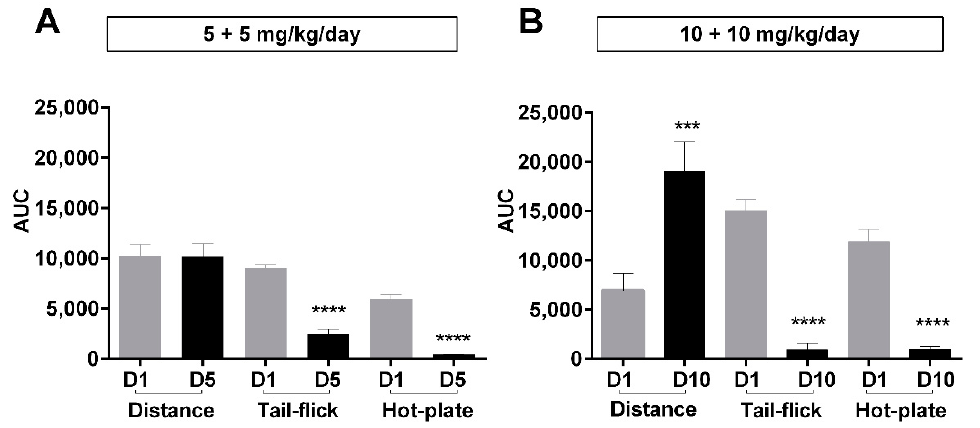
Figure 5. Overall behavioral and antinociceptive effects after long-term morphine administration. Area under the curves (AUC) for distance travelled and antinociception over a period of 180 min post-administration of subcutaneous morphine at different days through a treatment period. The curves used to calculate these AUC values are shown in Figure 1A and Supplementary Figures S4A and S6. Morphine was administered daily as 5 mg/kg (b.i.d.) ( A ), 10 mg/kg b.i.d. over 5 days, or ( B ) 10 mg/kg b.i.d. over 10 days. D1, D5, and D10 represent day 1, day 5, and day 10, respectively. Antinociception was assessed by tail-flick assay (TF) and hot-plate assay (HP). Values are presented as mean ± SEM ( n = 6 animals per group). Statistically significant ( p < 0.05) differences from day 1